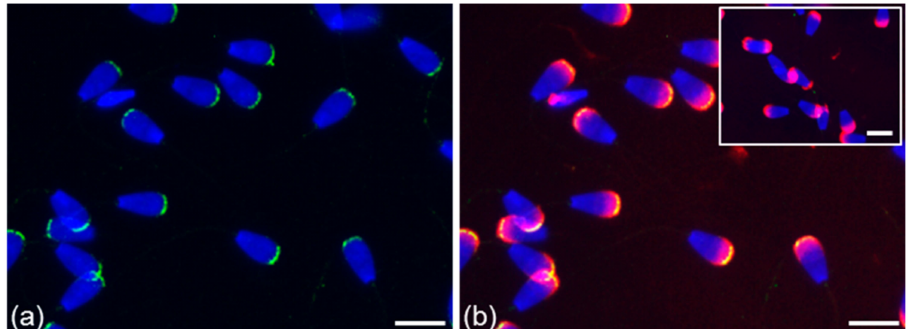
Figure 3. Localization of ESR1 in freshly ejaculated bull spermatozoa. Spermatozoa stained in the apical region of head with polyclonal antibody HC-20 (green) ( a ); spermatozoa stained with HC-20 (green), and sperm acrosomes labeled by PNA lectin (red) ( b ); nuclear DNA stained by DAPI (blue). Rabbit IgG isotype control is situated in the top right corner. Scale bar is 10 µ m.